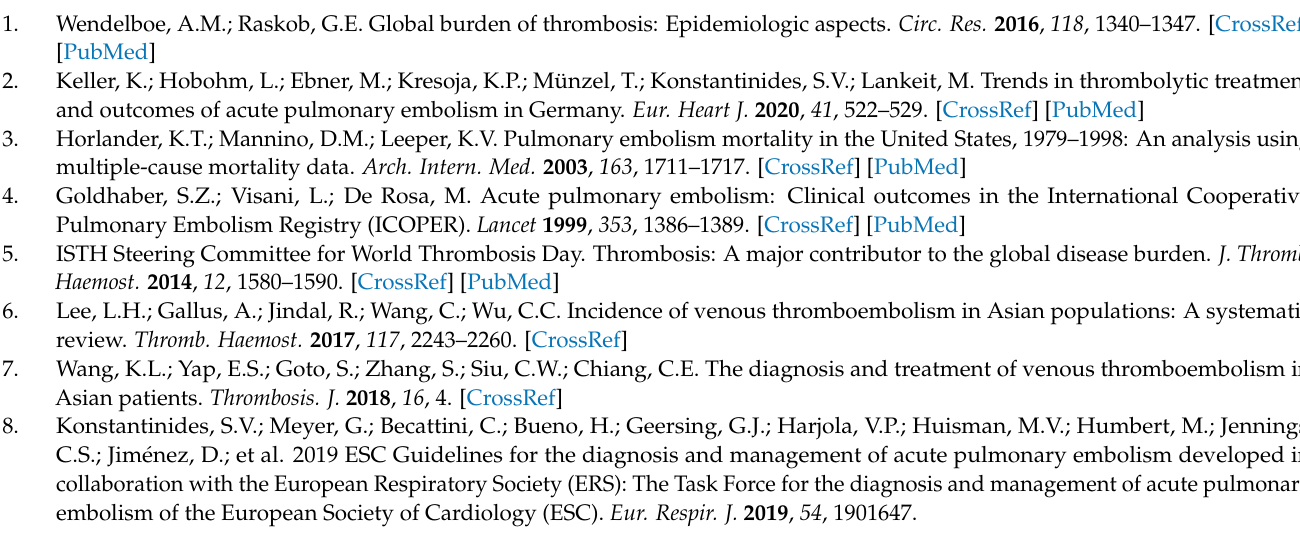
Embolism; Table S2: Cancer-associated Acute Pulmonary Embolism; Table S3: